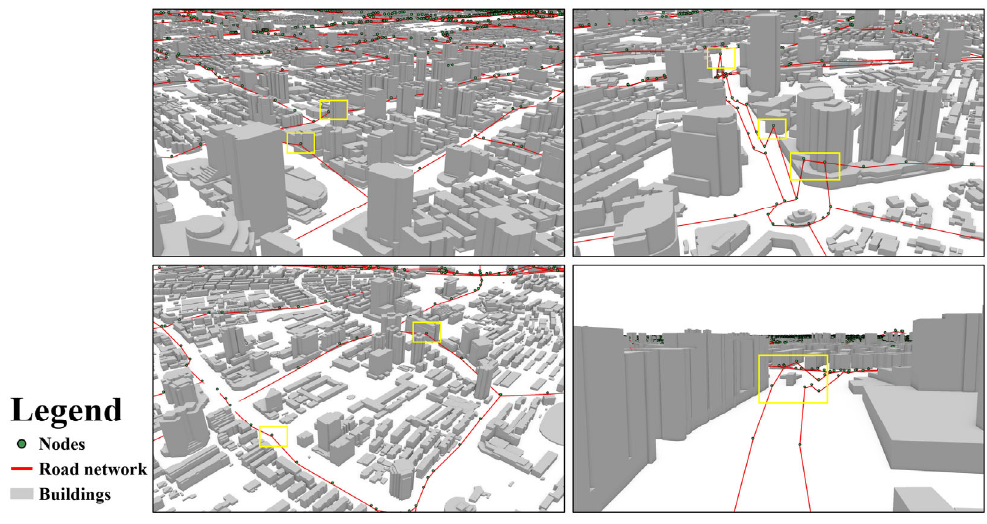
Figure 3. The original networks and errors with 3D building in urban